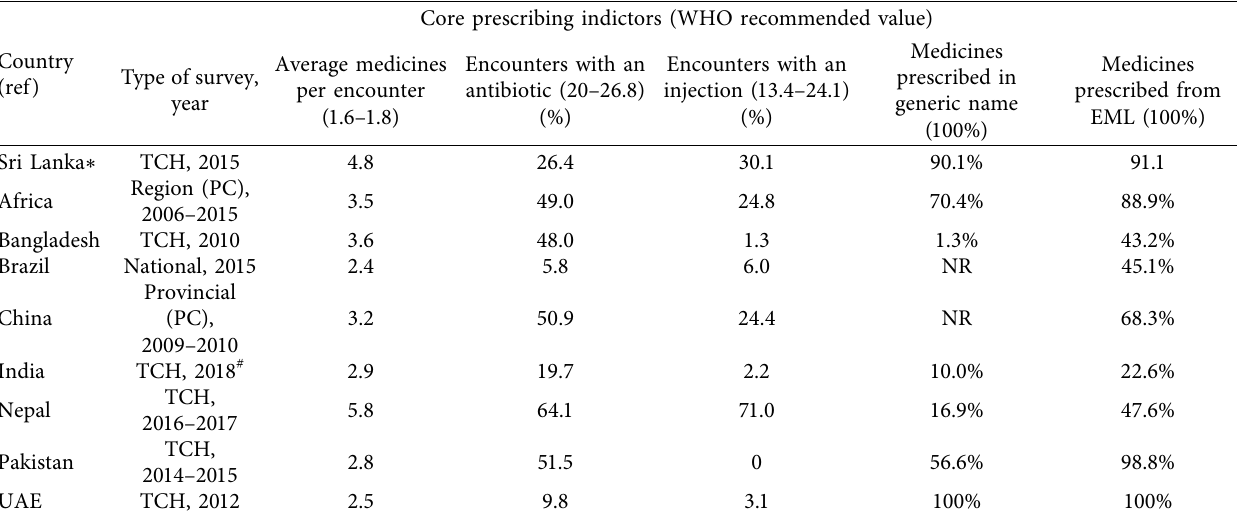
Table 4: Comparison of core prescribing indictors in different